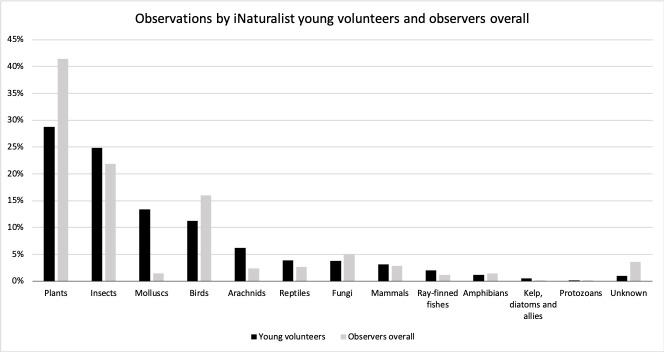
Comparison of contributed organisms by young volunteers and observers overall.This comparative bar chart shows the most observed organisms (%) by iNaturalist young volunteers taking part in this study (black bars) against the most observed organisms (%) observed by all iNaturalist users (grey bars). Young volunteers observe fewer plants and birds, but more molluscs, arachnids and insects.